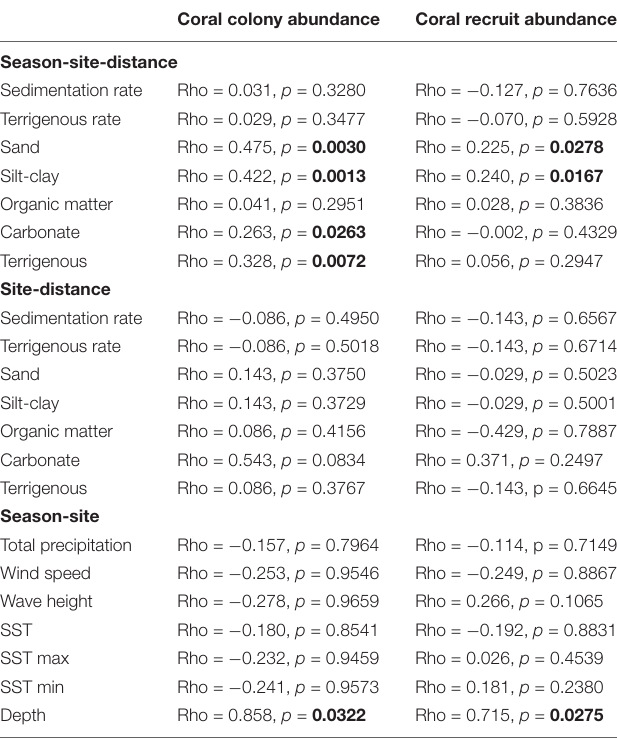
TABLE 3 | Summary of RELATE (spearman rank) correlation matrix for coral colony abundance, coral recruit abundance and environmental variables. Coral colony abundance Coral recruit